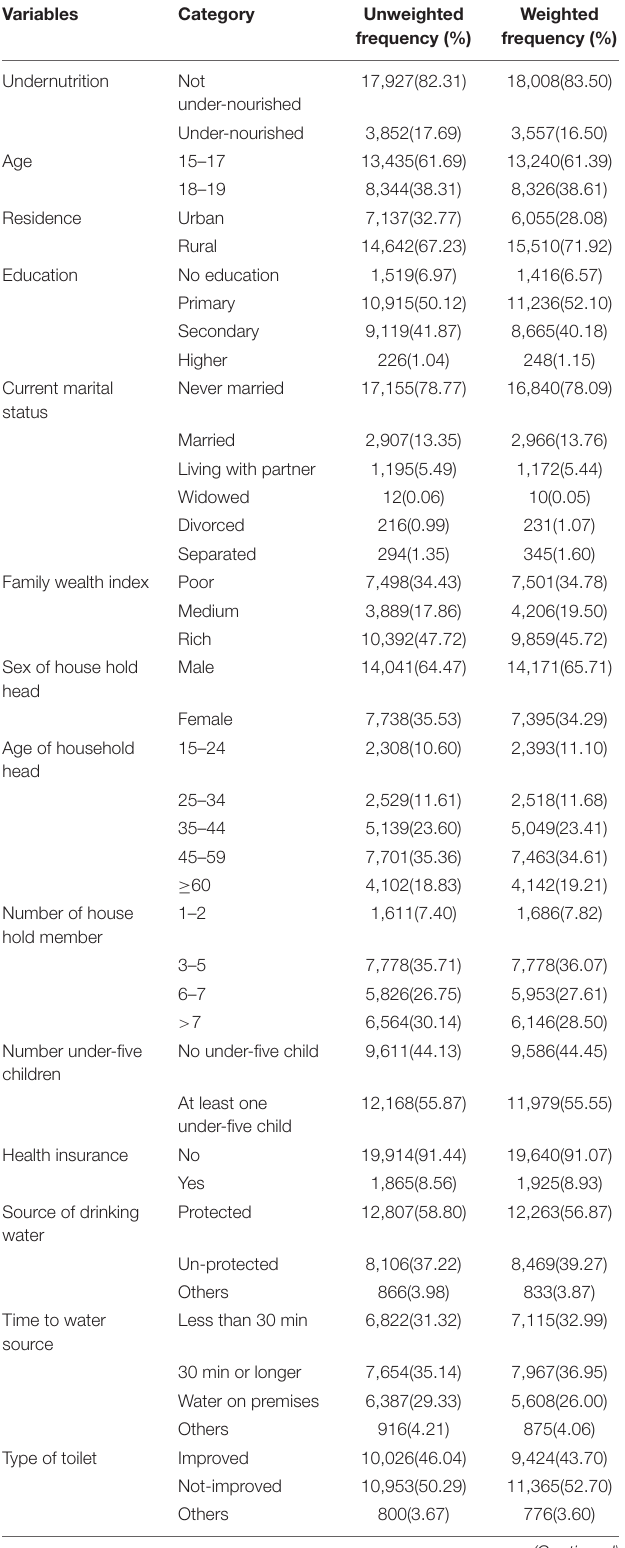
TABLE 2 | Sociodemographic and economic characteristics of 10 East African countries from 2010 to 2016. Variables